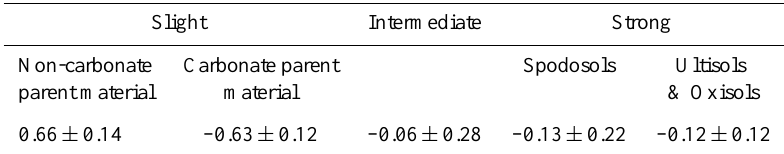
Table 3. Strain values in 50cm soils (mean ± sd, based on Table S3).